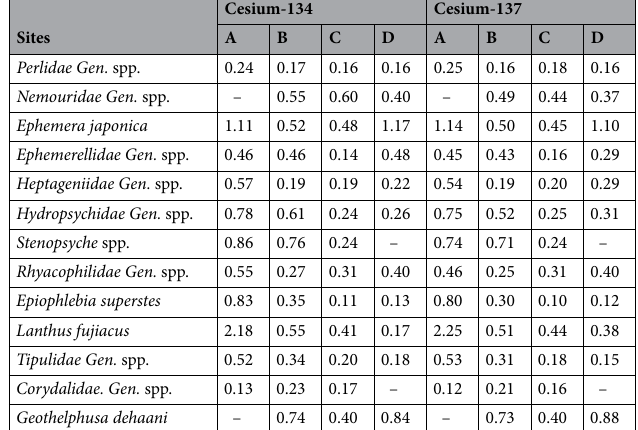
Table 4. Transfer coefficient in 13 groups of aquatic invertebrates at sites A, B, C and